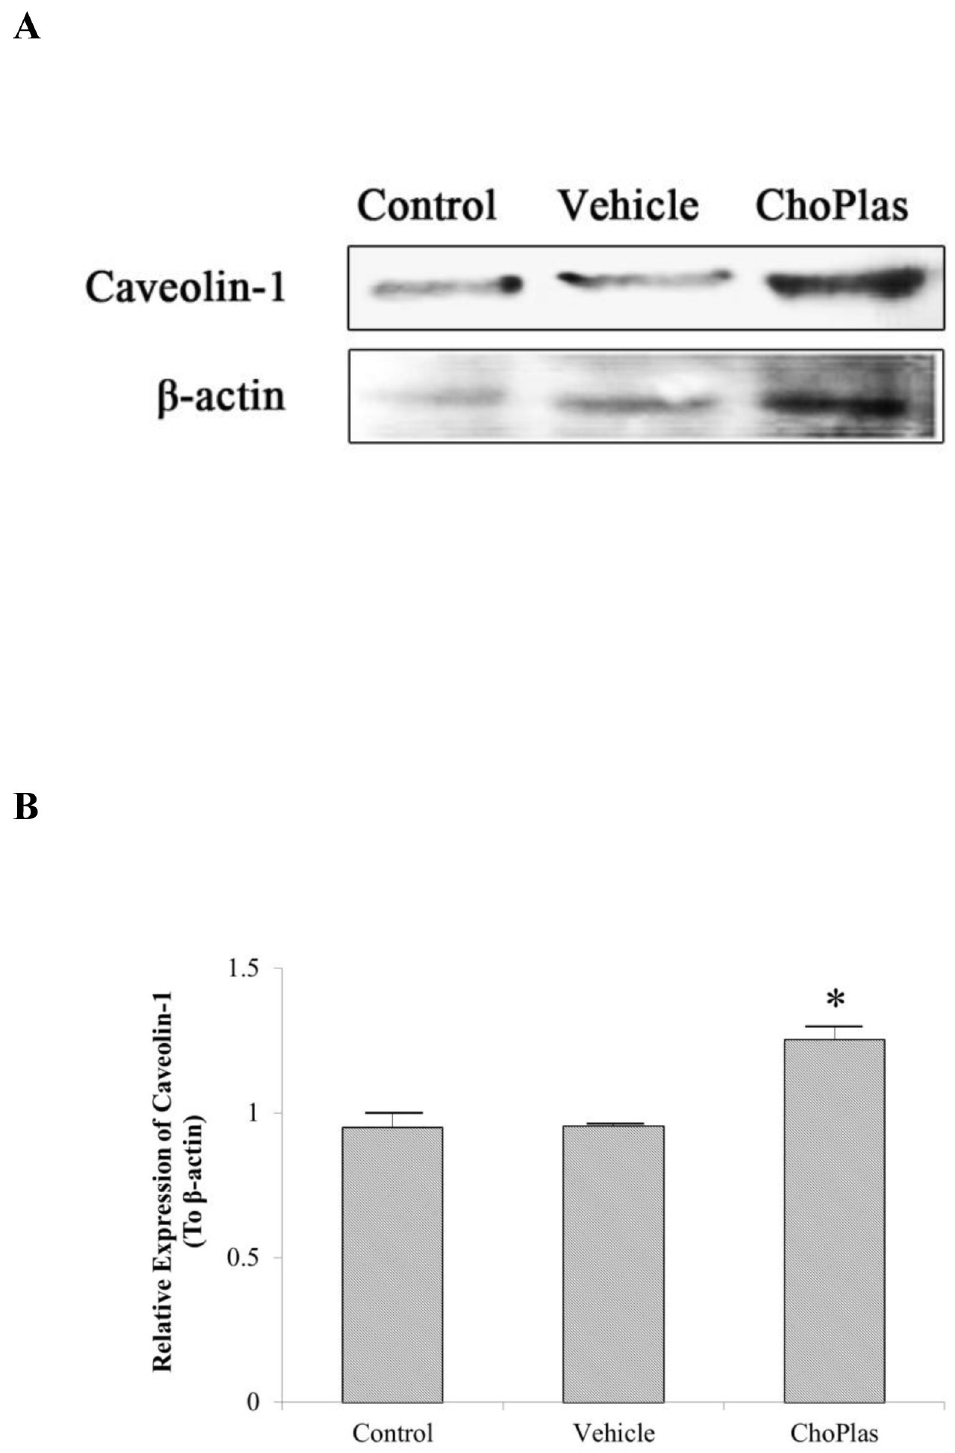
Figure 4. Effect of ChoPlas on Caveolin-1. CBRH7919 cells were treated with 25 μmol/L ChoPlas for 24 h and then harvested. (A)Total protein was extracted and then blotted with caveolin-1antibody; (B) Graph depicting the semi-quantization of caveolin-1expression computed using Image J software. Data are presented as the mean±S.D(n=3).